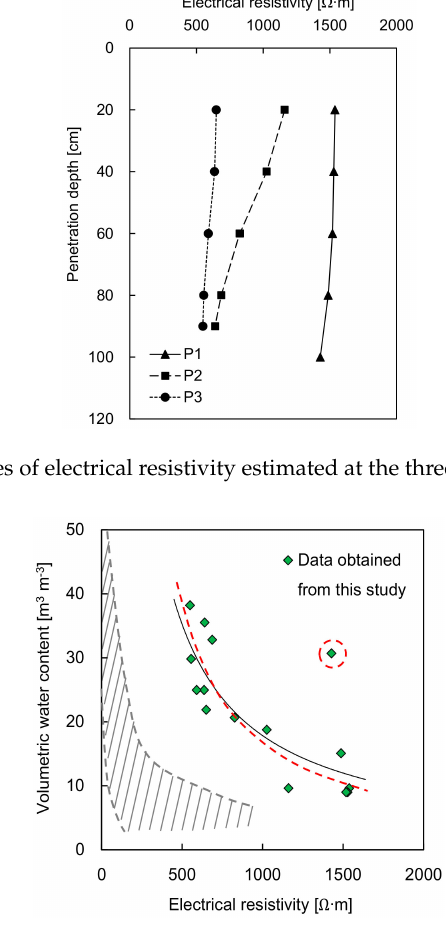
Figure 12. Relation between water contents and electrical resistivity, with a comparison of the data range reported by Calamita et al. [48]. The red dashed curve indicates the trend, excluding the data point marked with a red